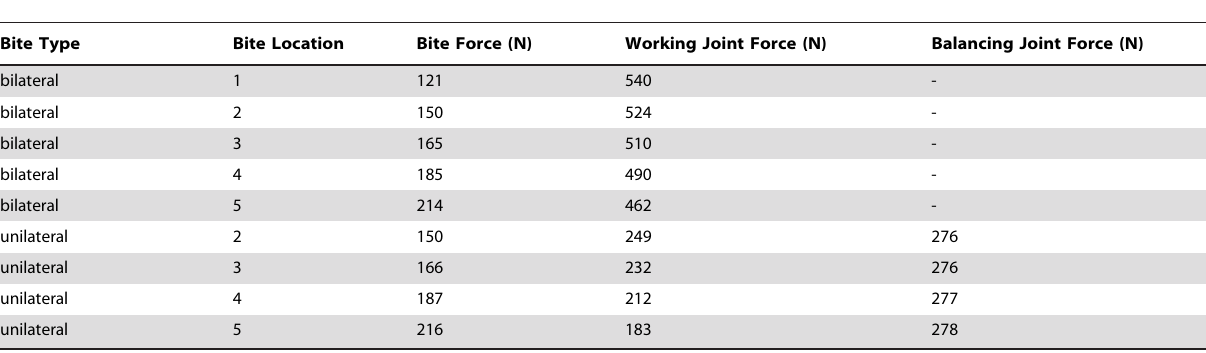
Table 2. Bite forces and jaw joint forces predicted by the